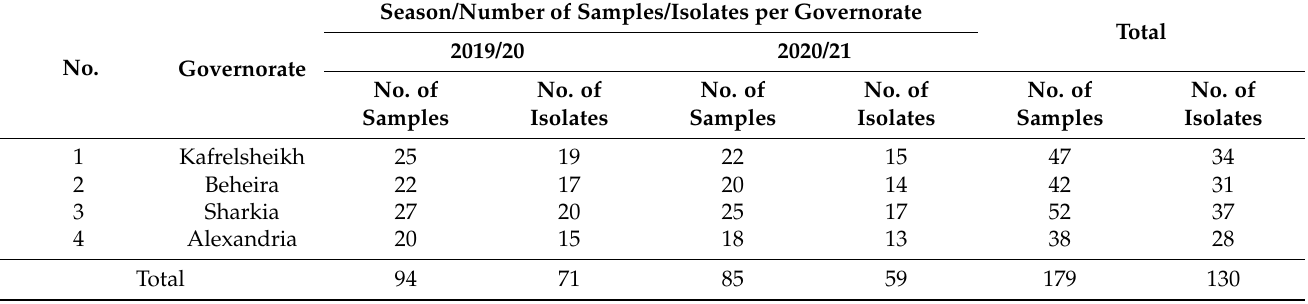
Table 1. The number of wheat leaf rust samples and isolates obtained from different growing governorates in Egypt, during the 2019/20 and 2020/21 growing